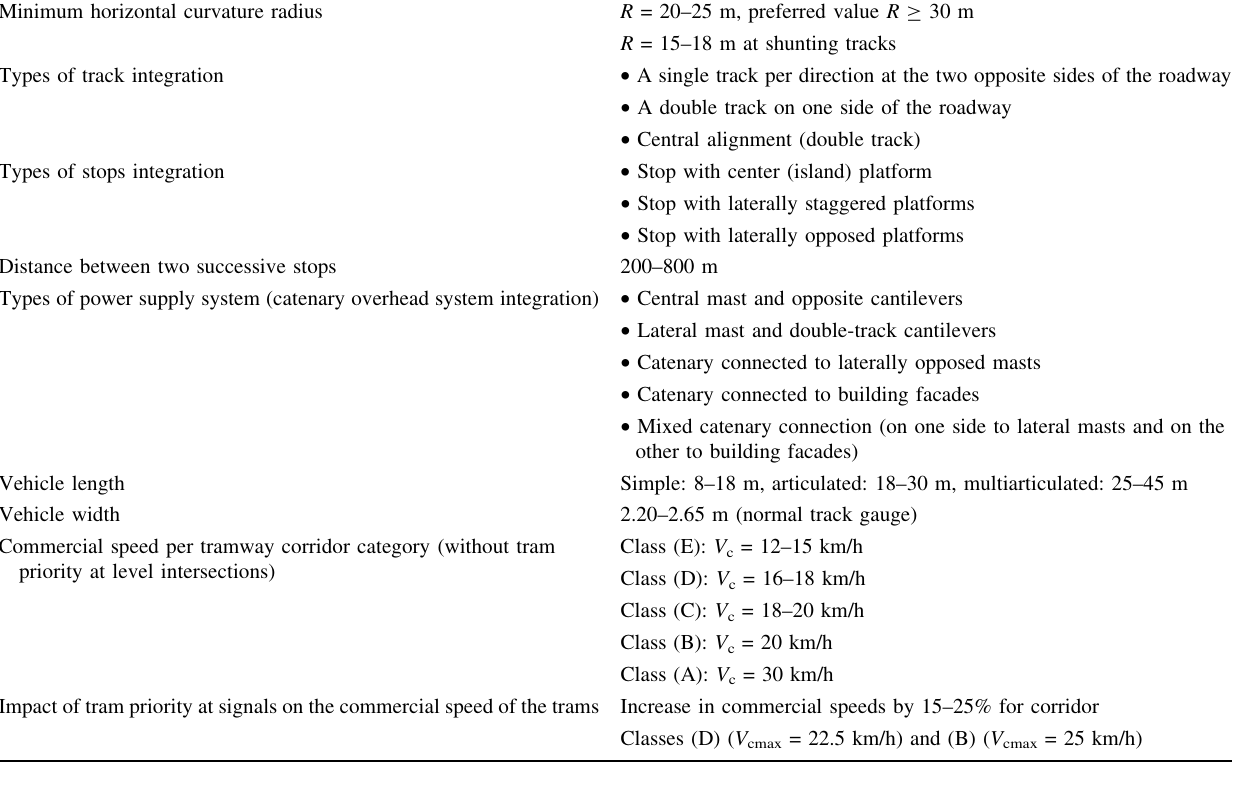
Table 1 Features and main characteristic values related to tramway systems Minimum horizontal curvature radius